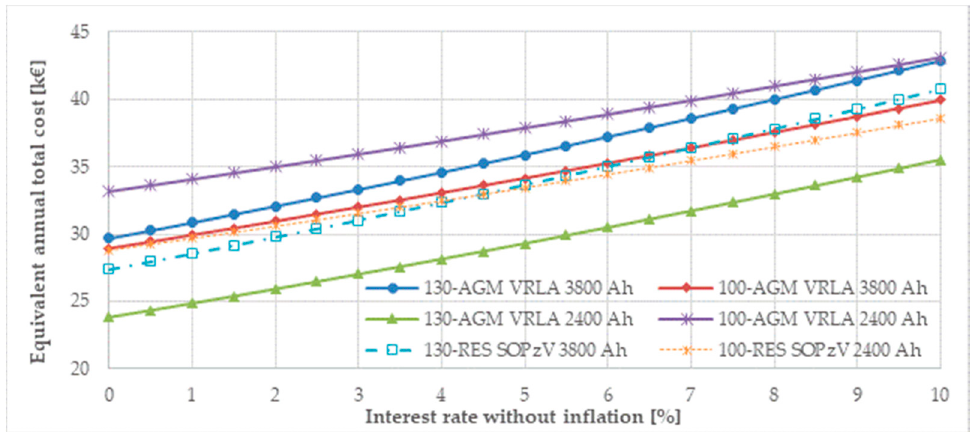
Figure 14. Equivalent annual total cost with respect to the interest rate without inflation combinations of PVs (100 or 130), battery type (AGM VRLA or gel RES SOPzV), and capacities (2400 or 3800 Ah).